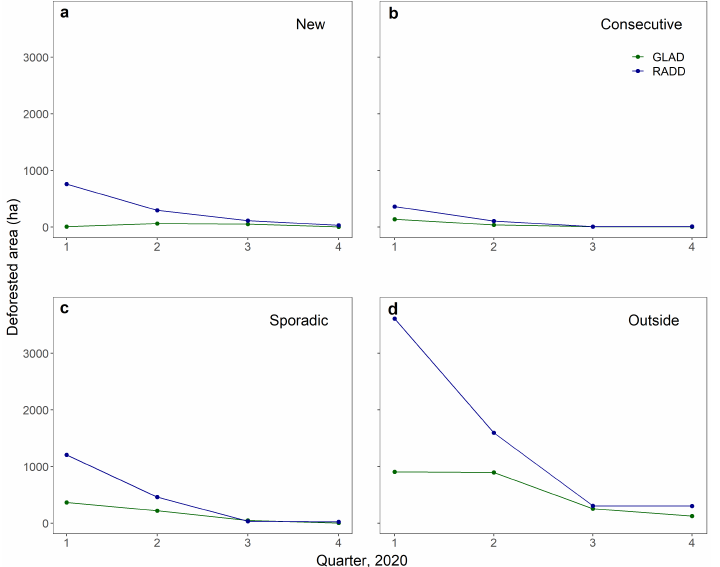
Figure 6. Quarterly summary of the deforested areas in 2020 for pixels inside and outside the hotspots. ( a – c ) pertain to those alerts inside new, consecutive and sporadic hotspots while ( d ) are those alerts outside hotspots